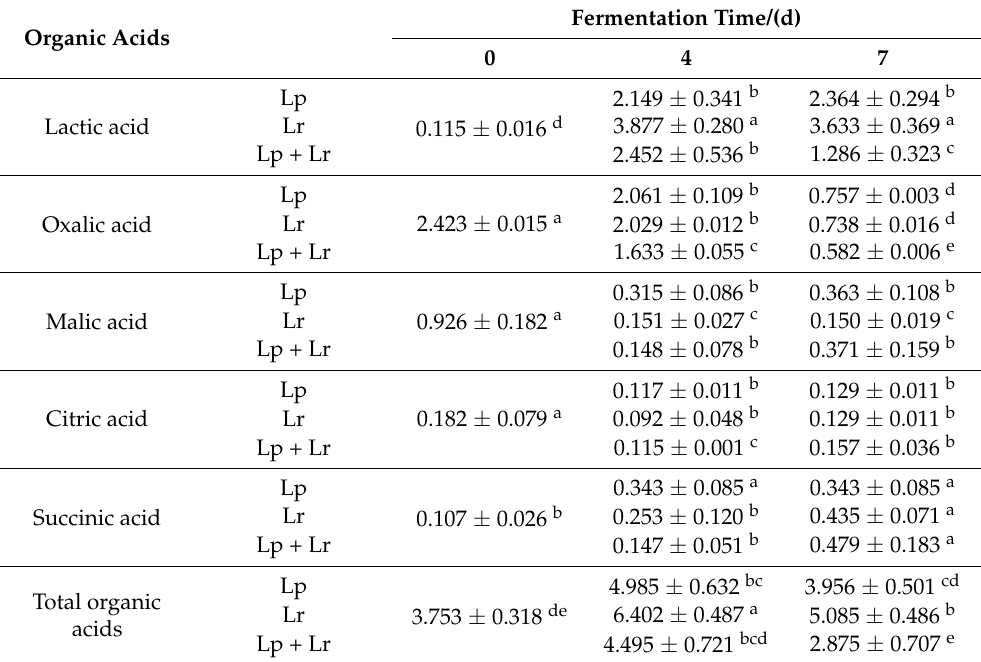
Table 2. The profile of organic acids content of edible grass during fermentation (mg/mL). Organic